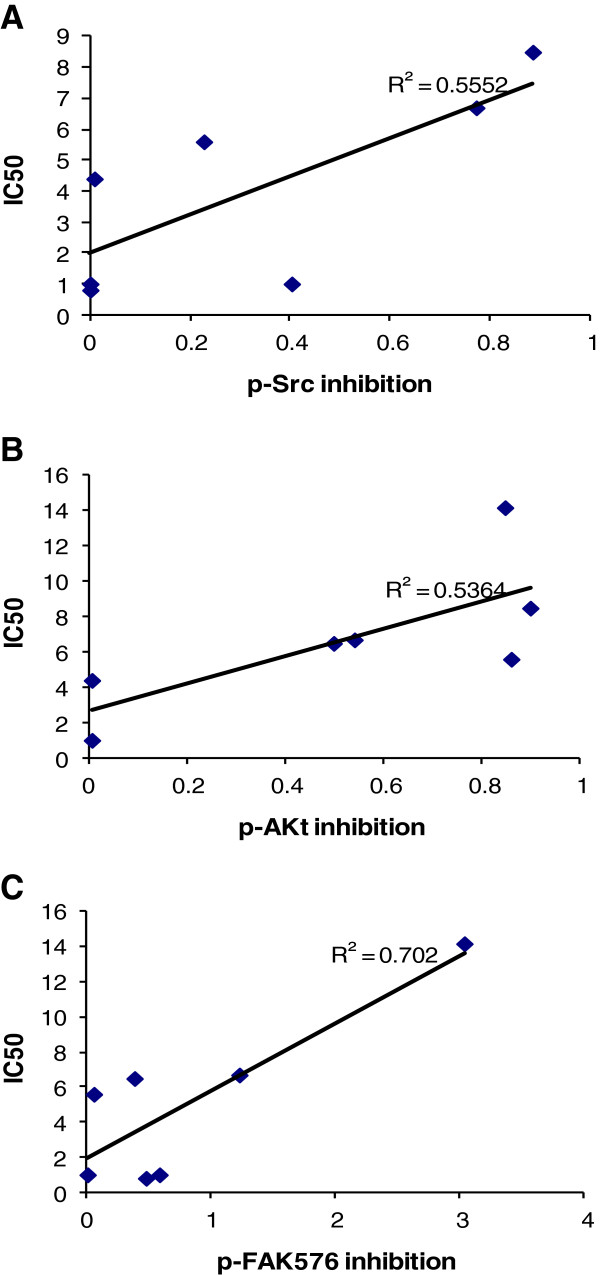
Correlation between the IC50 of dasatinib and the inhibition on the activity of Src, Akt, FAK. The inhibition levels of p-Src, p-Akt and p-FAK were measured when cells were treated with dasatinib at the dosage of 1uM and analyzed by ImageJ software. To analyze the correlation amongst the inhibition of different activated proteins by dasatinib, the inhibition of activated protein is calculated by the following formula, forexample:pSrcD/β−actinDpSrcC/β−actinC, D for dasatinib treatment, C for control. A, 7 out of 9 studied HCC cell lines showed good correlation between IC50 and p-Src416 inhibition (r = 0.745, p = 0.03). B, 7 out of 9 studied HCC cell lines showed good correlation between IC50 and p-Akt473 inhibition (r = 0.732, p = 0.03). C, 7 out of 9 studied HCC cell lines showed good correlation between IC50 and P-FAK576/577 inhibition (r = 0.838, p = 0.01).